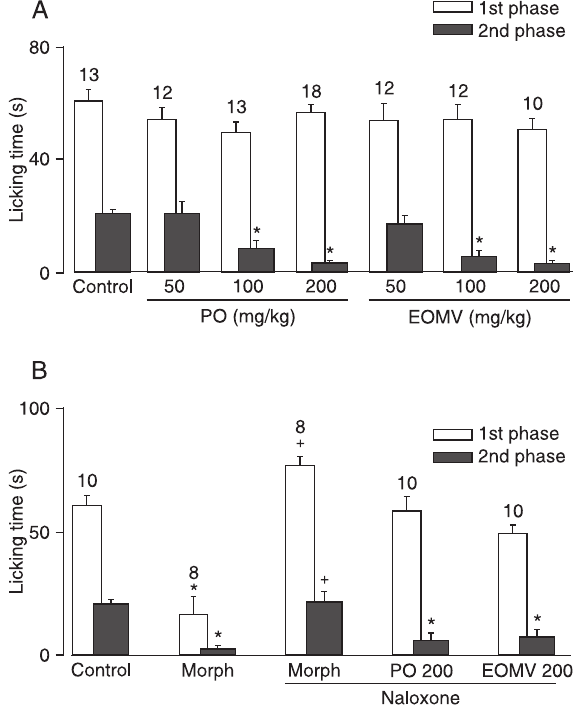
Figure 2. Inhibitory effect of the essential oil of Mentha x villosa (EOMV) and piperitenone oxide (PO) on the nociceptive reaction to intraplantar formalin injection. A , Effect of EOMV and PO (50, 100, and 200 mg/kg body weight) on the time spent licking the paw in the first and second phases of the nociceptive reaction. B , Absence of alteration by 2 mg/kg body weight naloxone adminis- tered subcutaneously of the EOMV- and PO-induced effects (200 mg/kg body weight) on the time spent licking the paw in the first and second phases of the nociceptive reaction. Morphine (Morph; 10 mg/kg) was administered intraperitoneally. Data are reported as mean licking time (± SEM). *P ≤ 0.05 compared to the respec- tive control; + P ≤ 0.05 compared to morphine in the absence of naloxone (ANOVA, Dunn test in Panel A and Mann-Whitney rank sum test in Panel B). The numbers above the columns indicate the number of mice in each